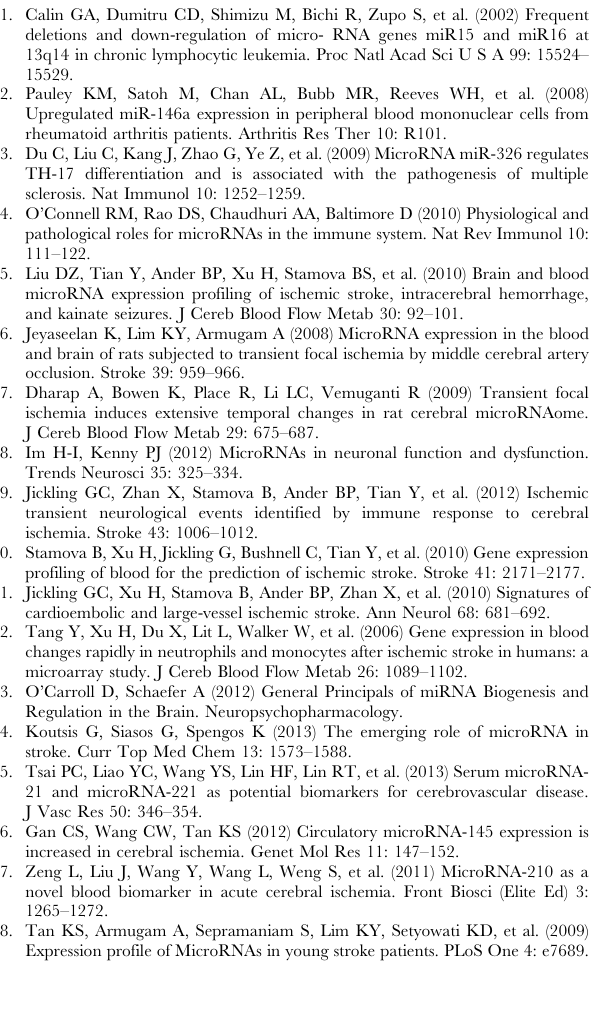
Table S2 Pathways previously associated with ischemic stroke by gene expression analysis of blood and the microRNA targeting genes in that pathway. Gene targets are experimentally observed or predicted with high probability to be